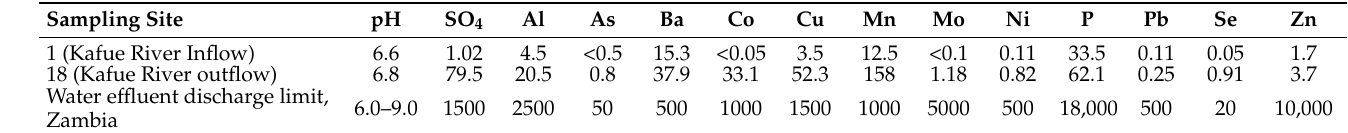
Table 2. The pH values, SO 42 − (mg/L), and selected trace element concentrations ( µ g/L) in filtered water at an inflow (Sampling site 1) and at an outflow (Sampling site 16) of the Kafue River to and from industrial part of the Zambian Copperbelt. Sampling period: 2008–2009, average values [74]. For sampling site location, see Figure 12. Water effluent discharge limits for Zambia [117] are given for comparison.